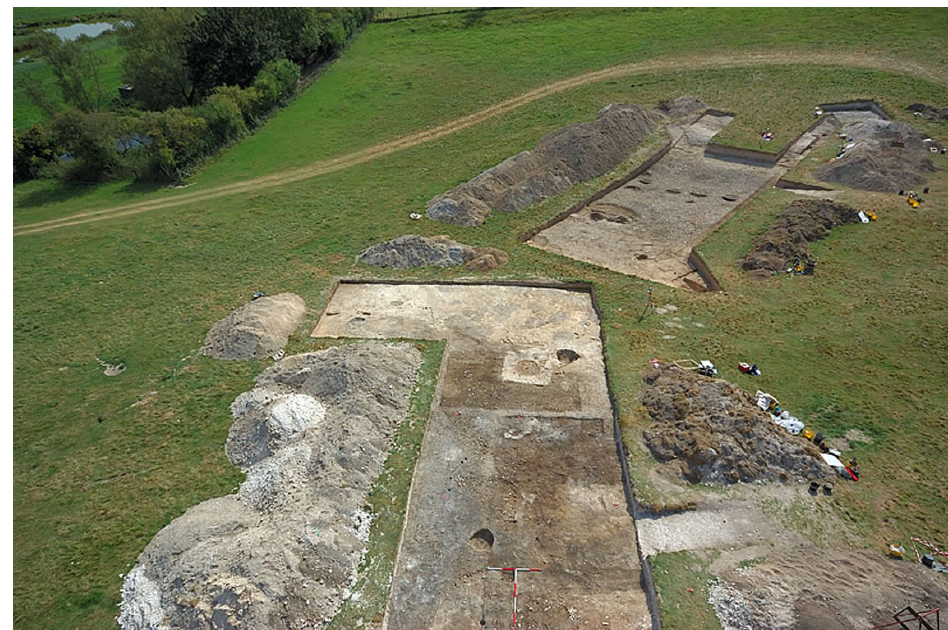
Fig. 5: Excavations at Durrington Walls by the Stonehenge Riverside Project (photo: Adam